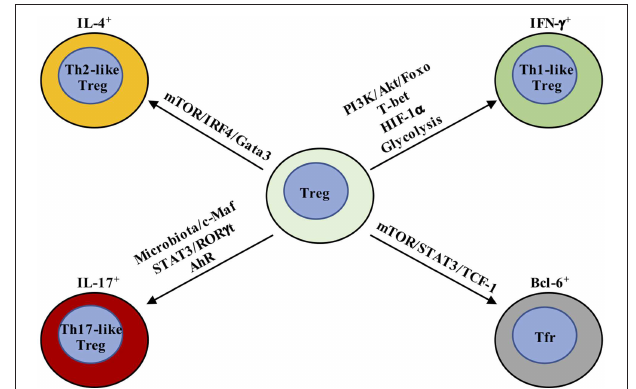
FIGURE 2 | Metabolic and transcriptional regulation orchestrates Treg cell plasticity. Th1-like Treg cells are T-bet + and express IFN- γ , whose differentiation is driven by IL-12-mediated PI3K/Akt/Foxo activation. In addition, HIF-1 α increases IFN- γ expression by enhancing glycolysis and directly binding Ifng gene to promote Th1-like Treg cell differentiation. Th2-like Treg cells are characterized by the expression of Gata3 and IRF4 and production of IL-4 and IL-13. TCR and downstream mTOR activation promote IRF4 expression to facilitate Th2-reprogramming in Treg cells. Th17-like Treg cells express ROR γ t in addition to Foxp3. IL-6 and downstream STAT3 activation are critical for the generation of IL-17-producing Treg cells. The tissue in which Th17-like Treg cells have been best characterized is the intestine, where Treg cells adapt to the local environmental cues, like microbiota and AhR ligands. T-follicular regulatory (Tfr) cells co-express Bcl-6 and Foxp3. mTORC1 promotes the phosphorylation of STAT3 and induces the expression of TCF-1 to drive Bcl-6